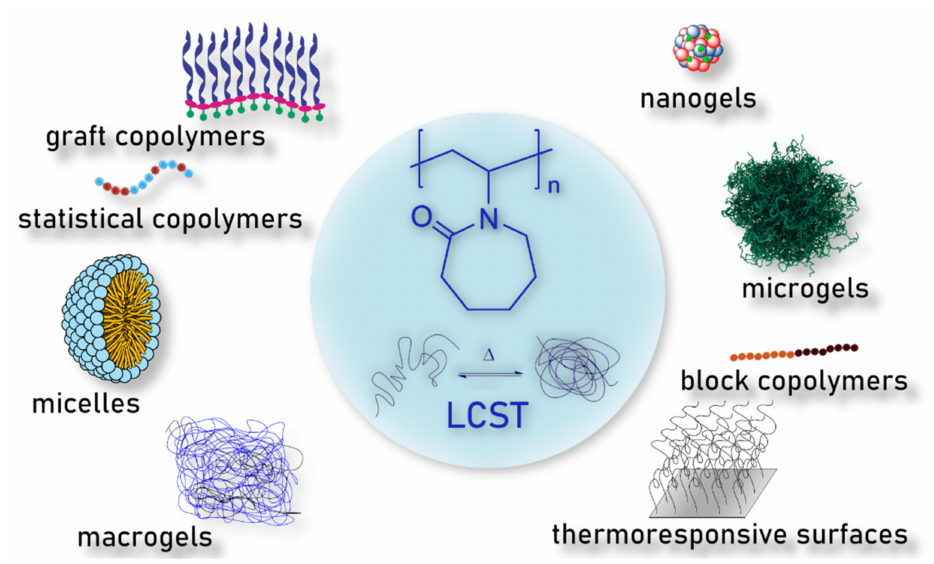
Figure 8. Schematic representation of PNVCL and its possible